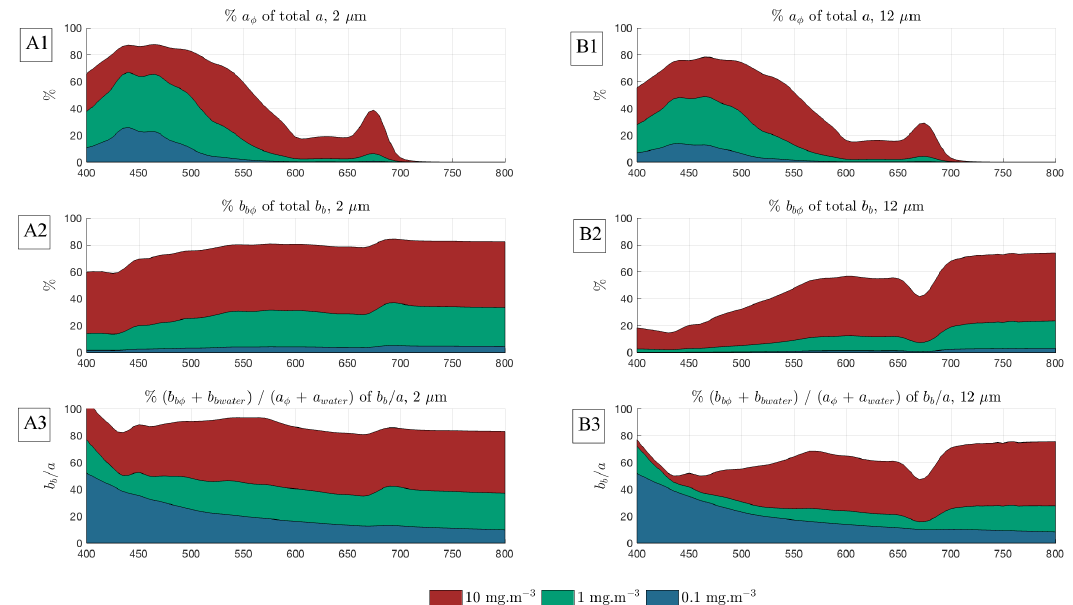
Figure 2. Example proportional phytoplankton to total Inherent Optical Property (IOP) contributions for Case 1 waters, for idealised eukaryote assemblages of 2 and 12 µ